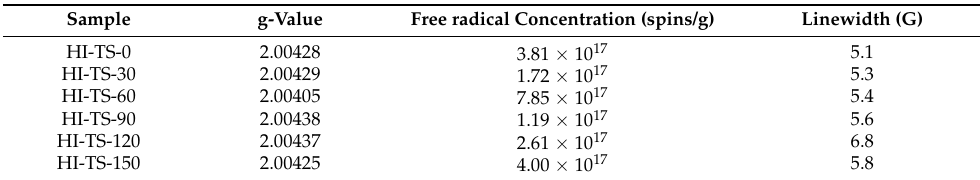
Figure 7. EPR spectra of HI-TS fraction of spinnable pitch at different incubation days. Table 5. Changes in free radical concentration, g-value, and linewidth of the HI-TS fraction of the spinnable pitch incubated for 150 days of extraction.